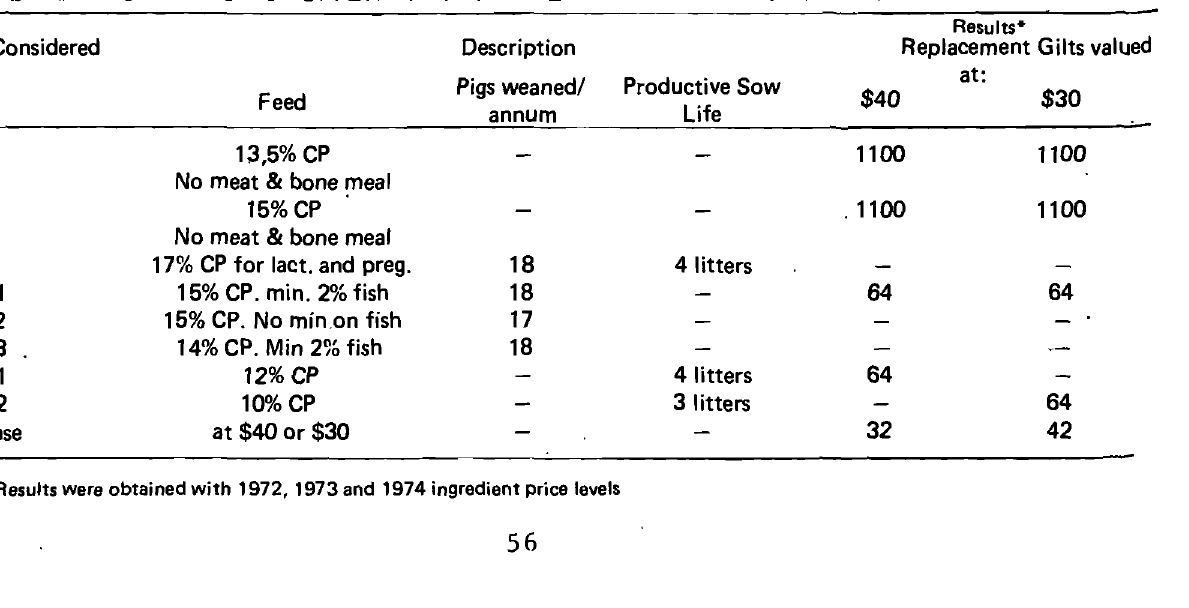
Table 2: PROCESSES CONSIDERED AND SELECTED IN PROFIT MAXIMIZING